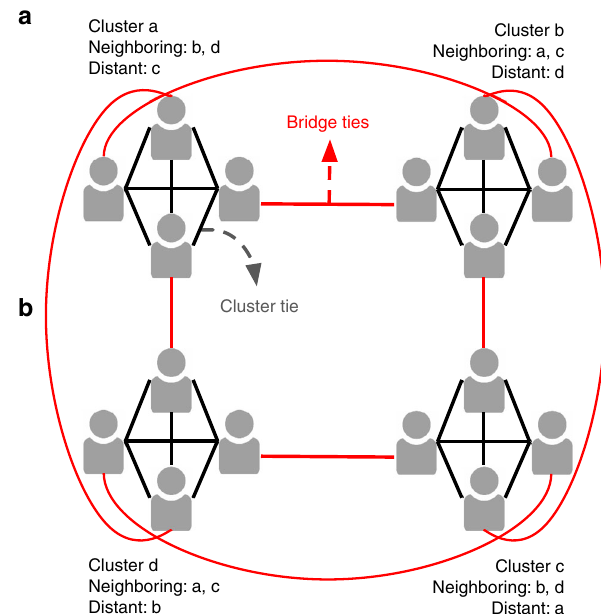
Fig. 1 A graphic summary of bridge ties (red), cluster ties (black), and clusters. For each cluster, its neighboring and distant clusters are shown. Mnemonic convergence is measured across the entire 16-member network. Average mnemonic similarity is measured (1) within cluster (among the four members of that cluster), (2) between a cluster and its neighboring cluster (e.g., cluster a and cluster b), and (3) between a cluster and its